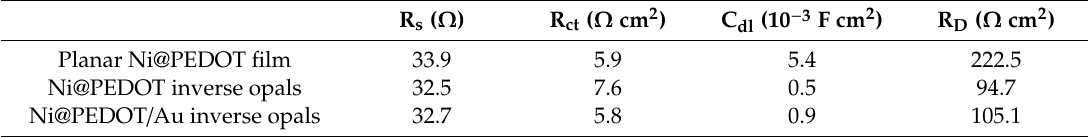
Figure 7. The complex impedance spectra for planar Ni@PEDOT film, as well as Ni@PEDOT and Ni@PEDOT/Au inverse opals in 0.1 M phosphate-buffered saline (PBS). Table 2. The fitting parameters and their values from impedance spectra of our